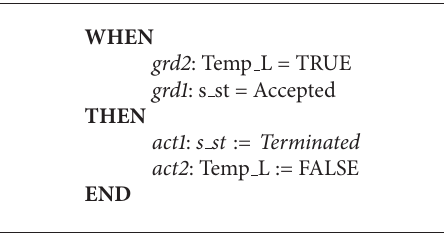
Algorithm 3: Events of second refinement.